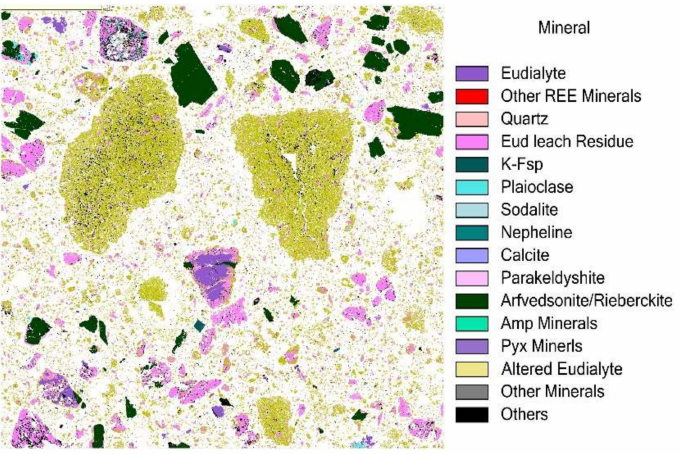
Figure 15. QEMSCAN analysis of eudialyte leach residue.